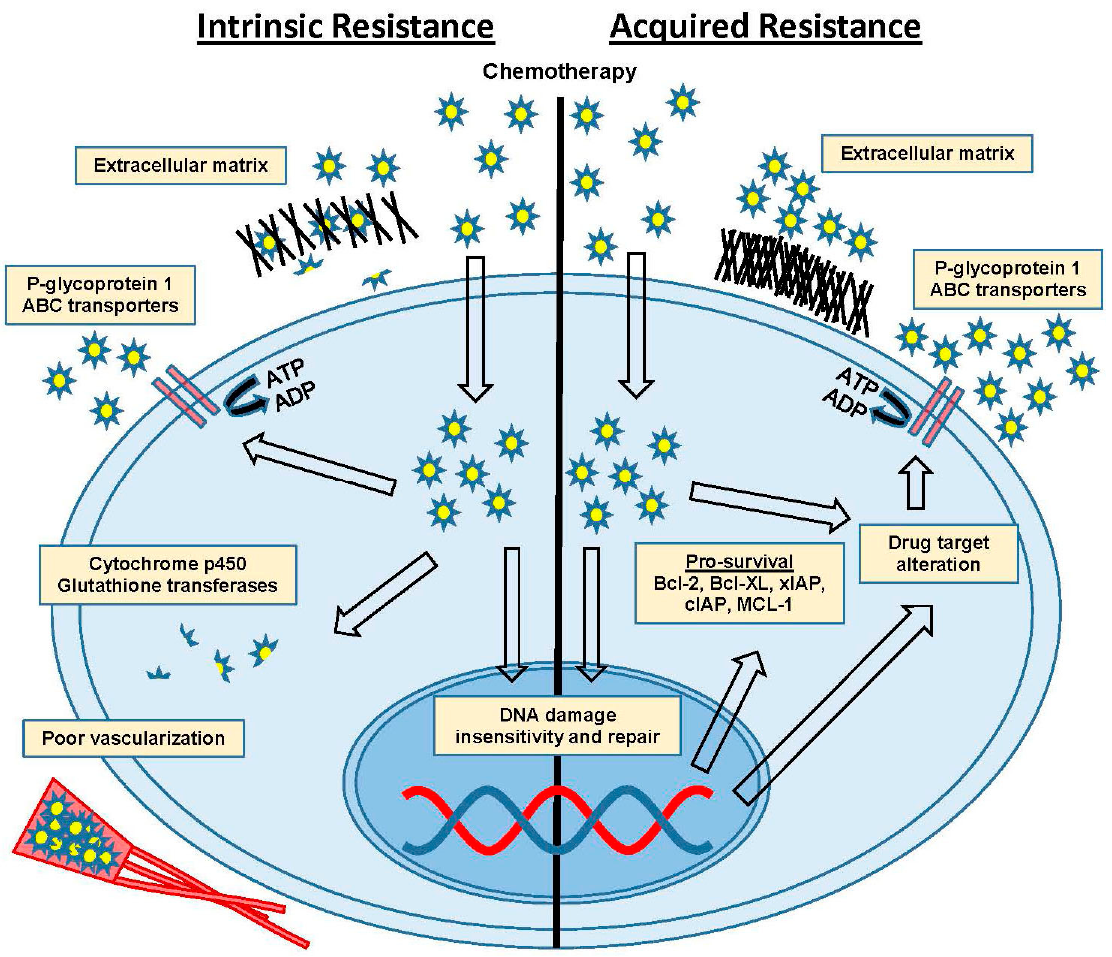
Figure 1. Intrinsic versus acquired resistance. Mechanisms of intrinsic and/or acquired chemoresistance include extracellular matrix proteins, P-glycoprotein (P-gp) efflux pumps and ATP binding cassette (ABC) transporters, cytochrome p450 and glutathione transferases, poor vascularization, DNA damage insensitivity and repair, drug target alteration and upregulation of pro-survival anti-apoptotic factors. Abbreviations: adenosine diphosphate (ADP), adenosine triphosphate (ATP), B-cell lymphoma 2 (BCL-2), B-cell lymphoma-extra large (BCL-XL), myeloid cell leukemia 1 (MCL-1), X-linked inhibitor of apoptosis protein/cellular inhibitor of apoptosis (xIAP/cIAP).